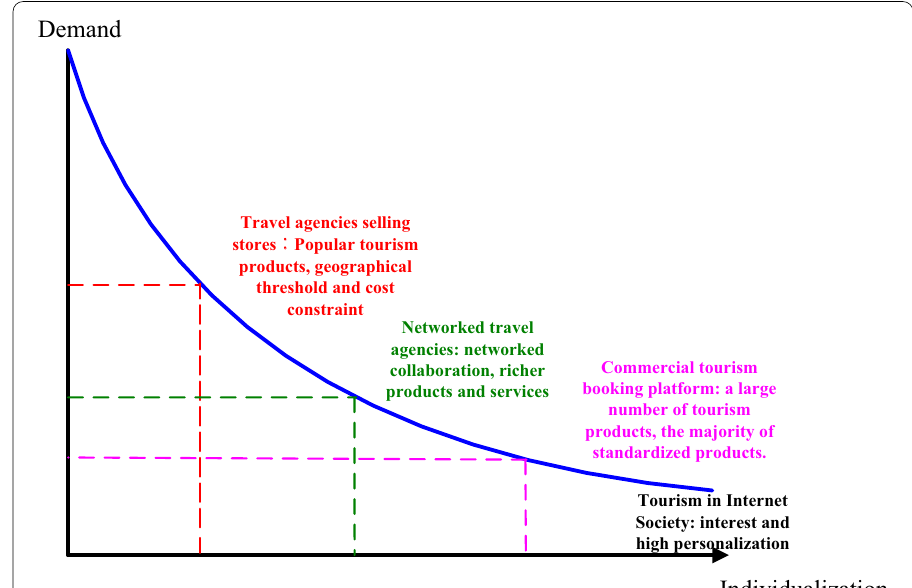
Fig. 4 Internet “long tail” promotes personalized tourism